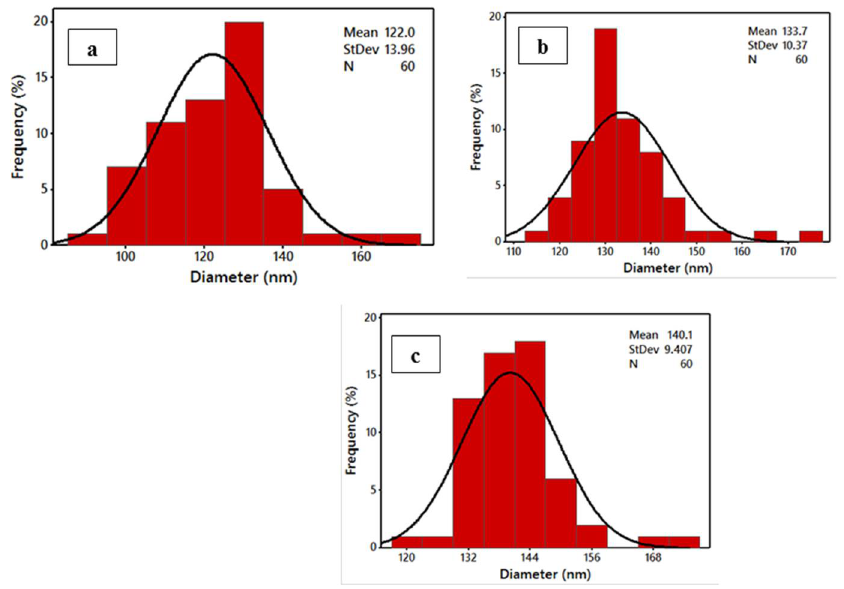
Figure 10. Diameter distribution histograms of the optimum condition experiment ( a ) and two different needle sizes: ( b ) 22 G and ( c ) 24 G under optimum condition.